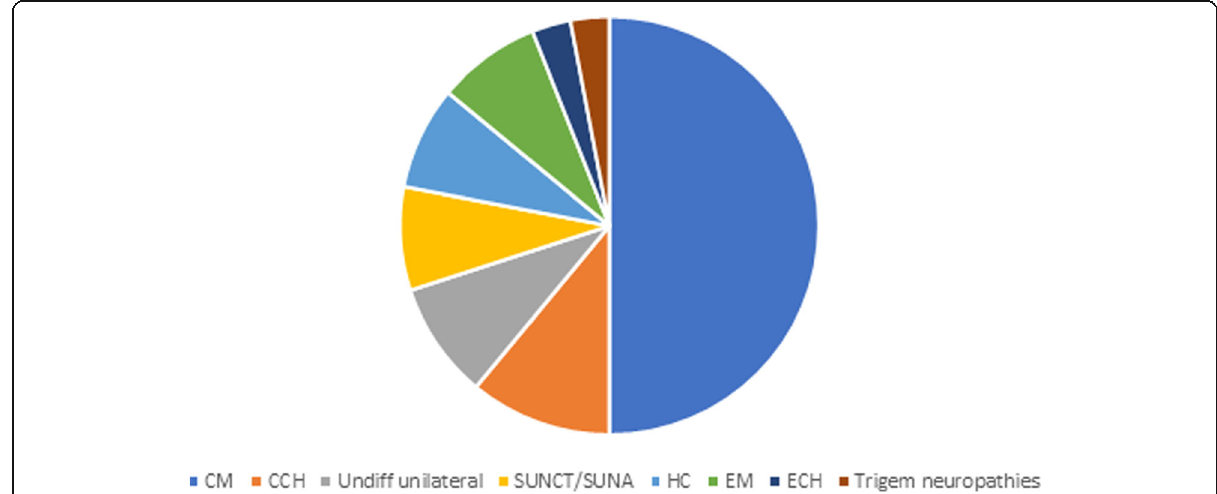
Fig. 2 Summary of headache diagnoses in cohort 2. CM-chronic migraine, SUNCT- short-lasting unilateral neuralgiform headache with conjunctival injection and tearing, SUNA- short-lasting unilateral neuralgiform headache with cranial autonomic symptoms, ECH- episodic cluster headache, CCH- chronic cluster headache, HC- hemicrania continua, trigem neuropathies- trigeminal neuropathies, undiff unilateral- undifferentiated continuous lateralised headache, EM- episodic